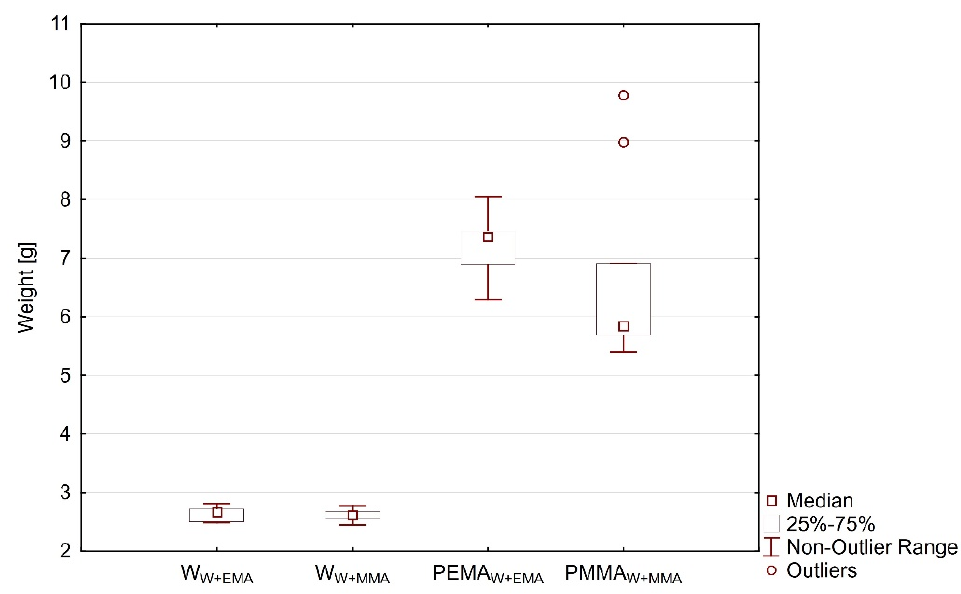
Figure 1. Boxplot of wood and acrylate polymer weight in the samples.